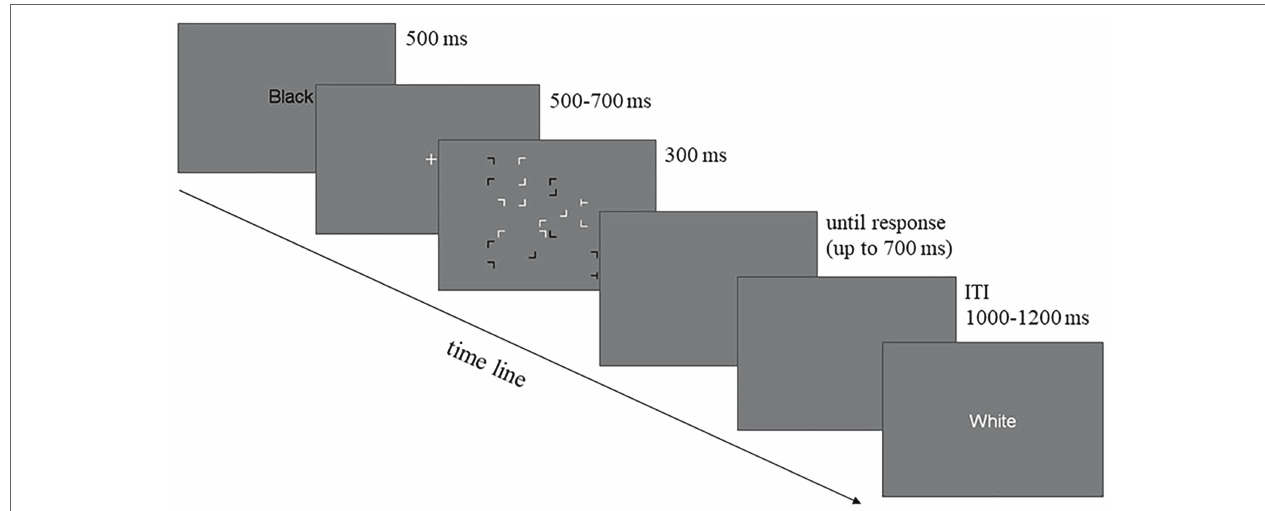
FIGURE 1 | Schematic illustration of the trial sequence in Experiment 1. A word cue (“Black” or “White”) was presented first, indicating the target color of the trial. After a 500–700 ms central fixation, the search display was rapidly presented for 300 ms, followed by a 700 ms blank screen both of which participants could use to produce the response (total of 1,000 ms). Lastly, the inter-trial interval was presented for 1,000–1,200 ms when the response window